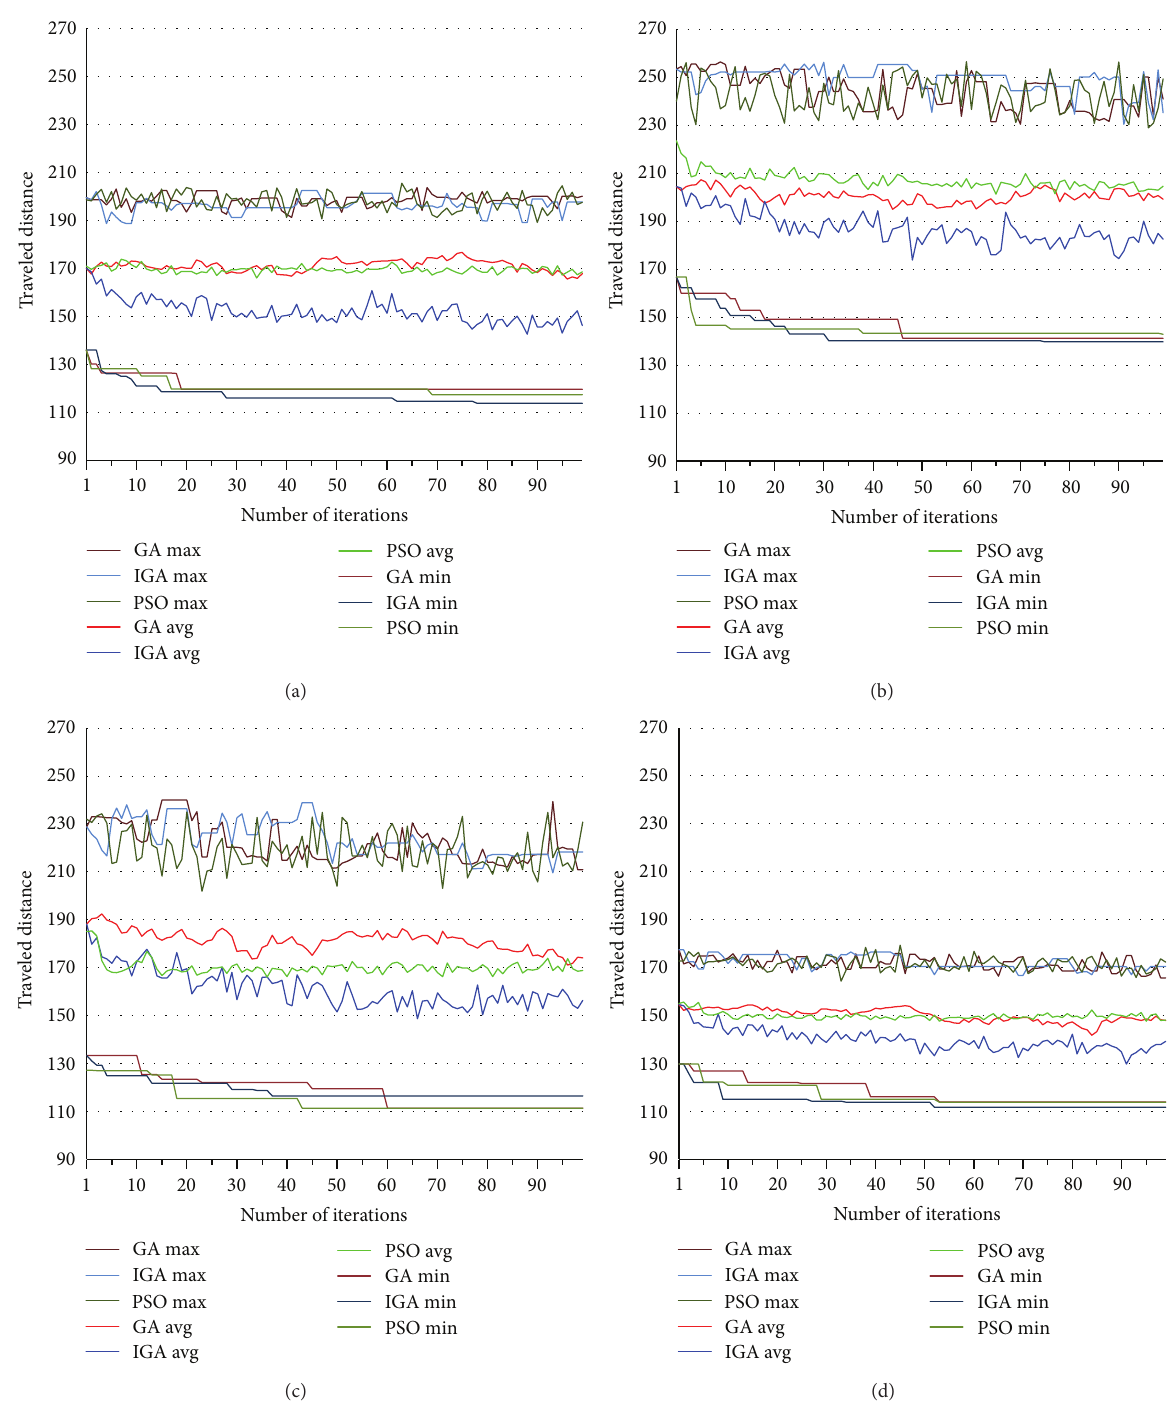
Figure 10: The shortest traveled distance for simulation results for Case 4. 15 goods overlap by GA, IGA, and PSO. (a) Goods type A, (b) goods type B, (c) goods type C, and (d) goods type